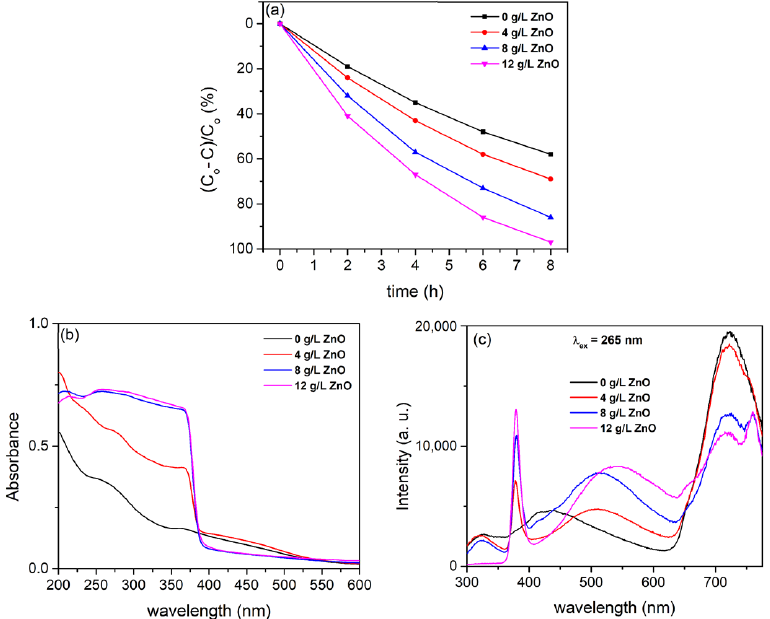
Figure 7. ( a ) PA of MgAl/ZnO coatings formed in aluminate electrolyte with addition of ZnO particles in various concentrations; ( b ) DRS spectra of MgAl/ZnO coatings formed in aluminate electrolyte with addition of ZnO articles in various concentrations; ( c ) PL spectra of MgAl/ZnO coatings formed in aluminate electrolyte with addition of ZnO particles in various concentrations. PL emission spectra of MgAl/ZnO coatings are shown in Figure 7c. The overall PL of MgAl/ZnO coatings is a sum of PL originating from MgAl coatings and ZnO. The sharp near-ultraviolet emission band centered at about 380 nm is attributed to the radiative recombination of free excitons in ZnO [42]. Further, ZnO particles showed a broad green emission band centered at about 510 nm, which originated from oxygen vacancy and zinc vacancy-related defects [43]. This PL is superimposed in the range from 400 nm to 600 nm on the PL of the MgAl. The PL intensity of each of these PL bands increased as the concentration of ZnO incorporated into MgAl coatings